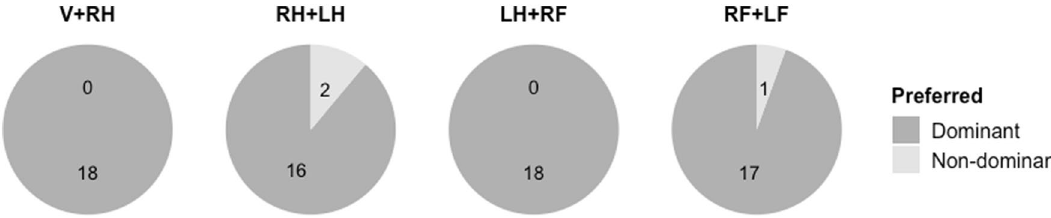
Figure 7. Distribution of preferred combinations among professional musicians. Out of 18 musicians, the dominant combination was preferred by 18 in V + RH, 16 in RH + LH, 18 in LH + RF and 17 in RF + LF.